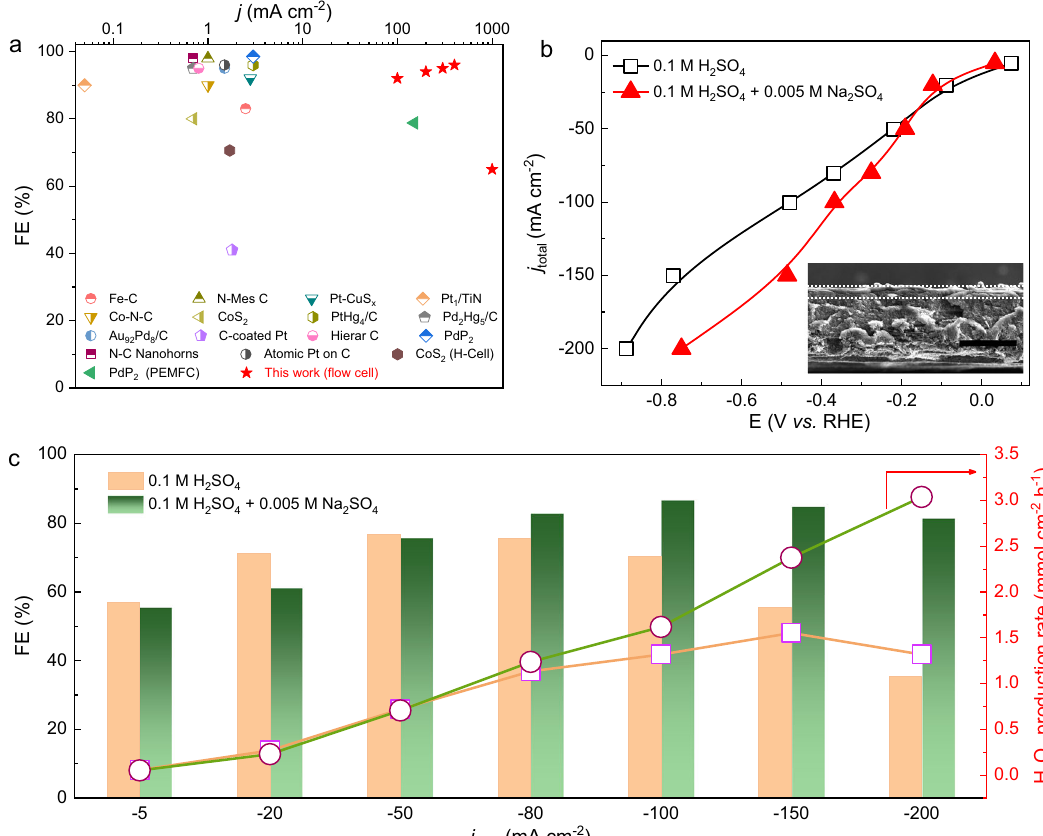
Fig. 2 Na + effects toward acidic H 2 O 2 generation through 2e − – ORR. a Reported current densities and Faradaic ef fi ciencies (FEs) for 2e − – ORR toward H 2 O 2 in acid in literatures (listed in Table S1). b Effect of 0.005 M Na 2 SO 4 on the total activity over carbon catalysts BP2000 in a fl ow cell. The cell voltages were 85% iR compensated. The inset is the cross-section SEM image of the electrode. The scale bar is 200 µ m. c The comparison of H 2 O 2 FE and production rate over carbon catalyst BP2000 with/without 0.005 M Na 2 SO 4 in a fl ow cell. The Na + serves as a promoter for the production of H 2 O 2 through 2e − – ORR. The H 2 O 2 FE and production rate are both increased, especially at the high current